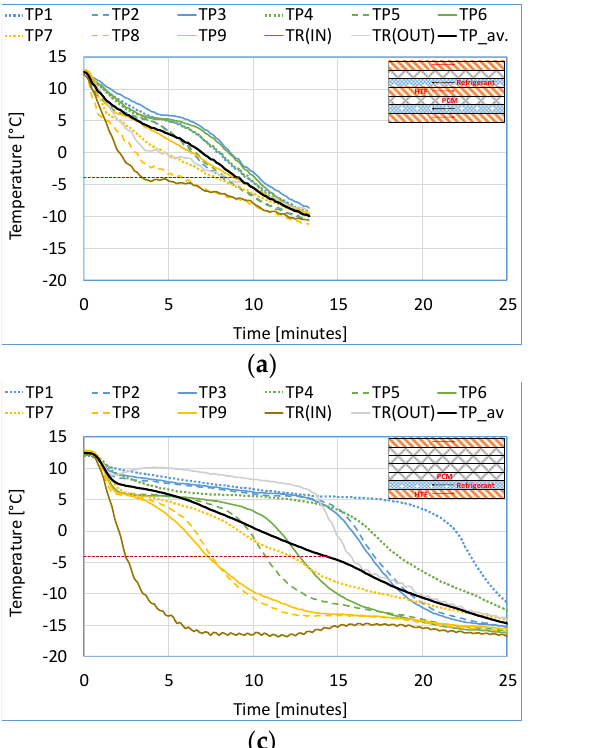
Figure 4. Temperature profiles of the charging process for ( a ) TES 1 , ( b ) TES 2 , ( c ) TES 3 , and ( d ) position of temperature sensors.